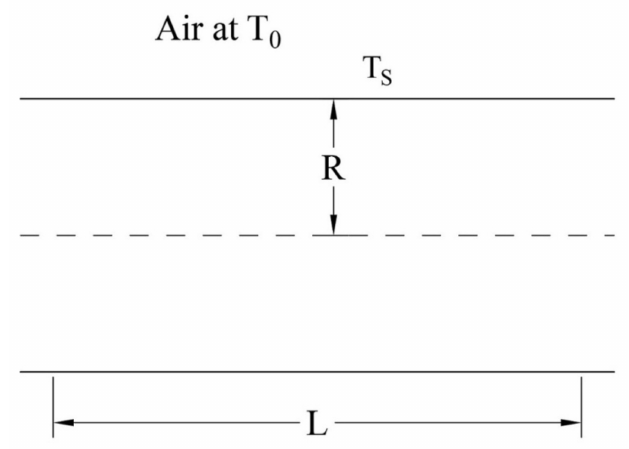
Figure 9. Geometry sketch of a cylinder.